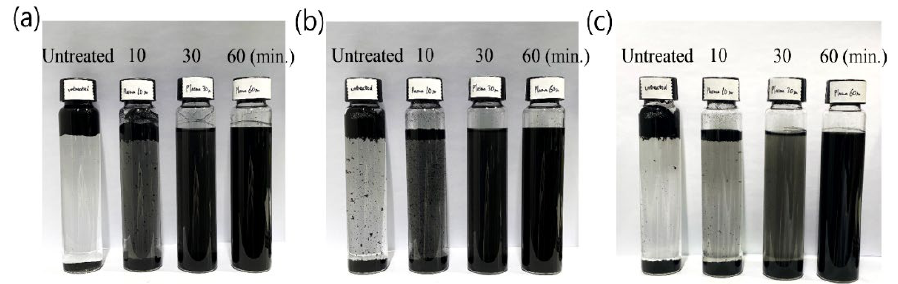
Figure 4. Images of the water dispersion test at different experimental settings. Water is added immediately ( a ) after the PAG treatment, ( b ) after a minute of stirring and left alone for 30 min, and ( c ) when samples from ( b ) are left alone for 24 h.